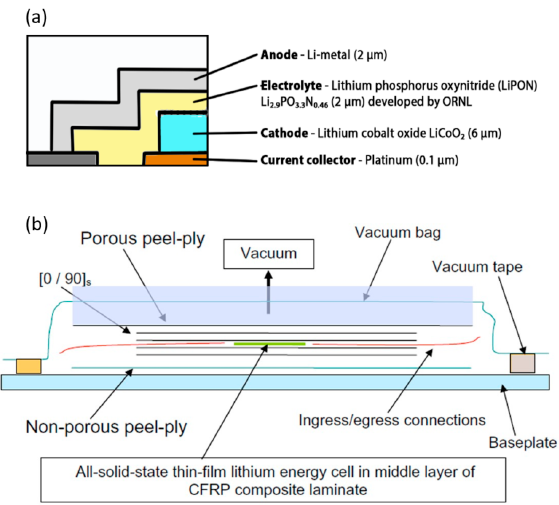
Figure 5. Integration of thin-film Li-ion energy cells in carbon fiber reinforced laminates. ( a ) All-solid-state thin-film lithium cell. ( b ) Schematic layup of thin-film lithium energy cell embedding in CFRP [6].